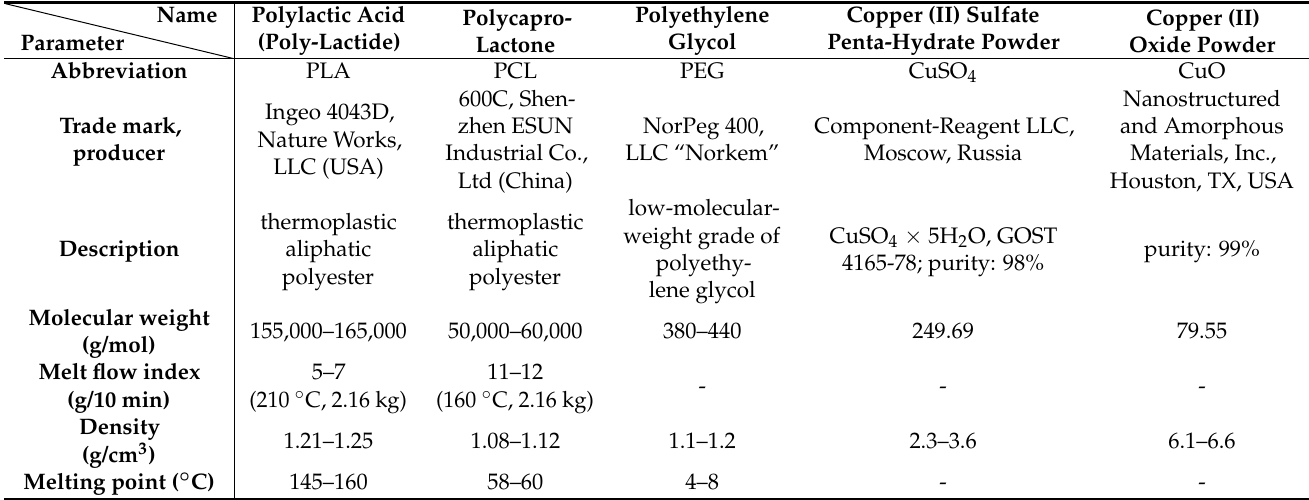
Table 1. Characterization of raw materials for the